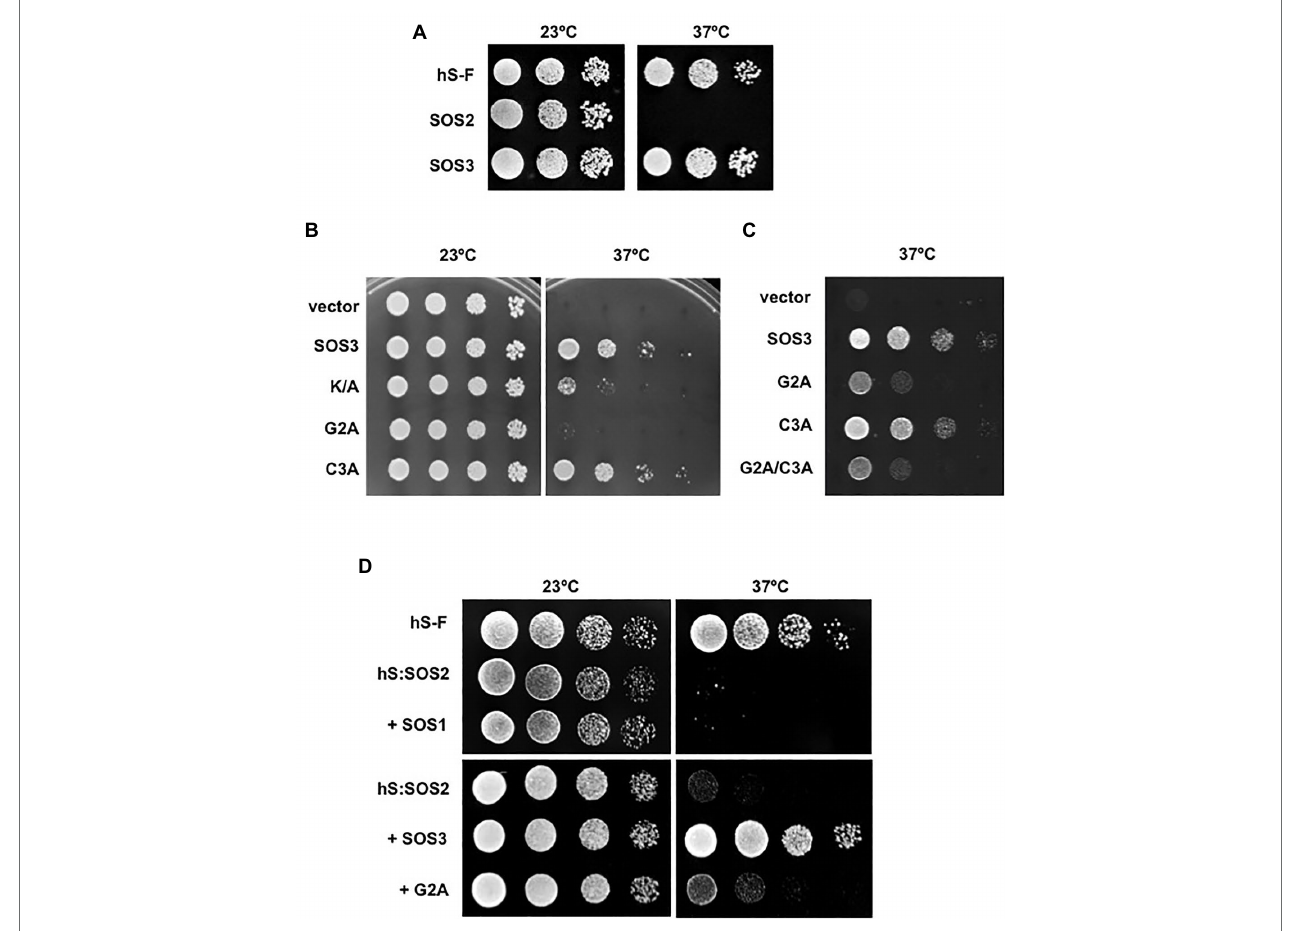
FIGURE 2 | Recruitment of SOS proteins to the plasma membrane. (A) SOS2 and SOS3 were fused with the hSos reporter protein and were expressed in the yeast strain cdc25-2 . Decimal dilutions were spotted onto duplicated selective plates and incubated at 23 ° C or 37 ° C. Growth at 37 ° C indicates recruitment to the plasma membrane. Plasmid pADNS–SosF encoding a hSos protein fused to Ras farnesylation signal (hS-F) was used as a positive control. (B) Wild-type SOS3 and mutants K/A, G2A, and C3A were fused with the reporter hSos and processed as in (A). Growth a 37 ° C indicates attachment to the plasma membrane. (C) Similar assay to that in (B) but using 10-fold higher culture densities for the drop-spots to compare the single SOS3 mutants G2A and C3A to the double mutant G2A/C3A. (D) SOS2 fused to the reporter hSos (hS:SOS2) was co-expressed with SOS1, wild-type SOS3, and the SOS3 mutant G2A. Samples were processed as in (A). Growth at 37 ° C indicates the recruitment of the hSos:SOS2 chimera to the plasma membrane. Farnesilated hSos protein (hS-F) was used as a positive